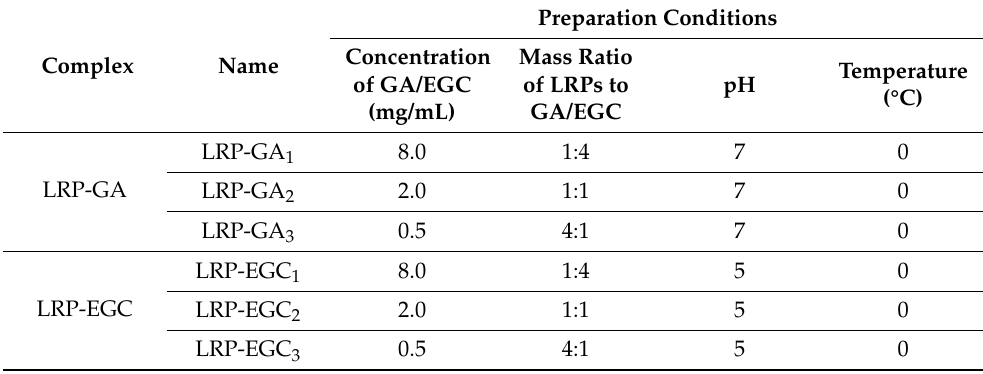
Table 1. Preparation conditions of LRP-GA and LRP-EGC complexes with different binding amounts of GA/EGC: concentration of GA/EGC (mg/mL), mass ratio of LRPs to GA/EGC, pH,